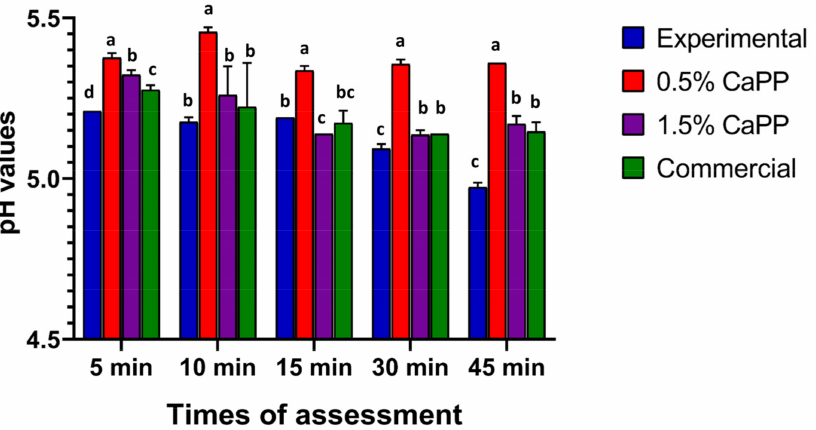
Figure 4. The pH mean values of the used bleaching gels in the different periods of assessment. Different letters in the bars indicate statistically significant differences among the groups ( p ≤ 0.05).